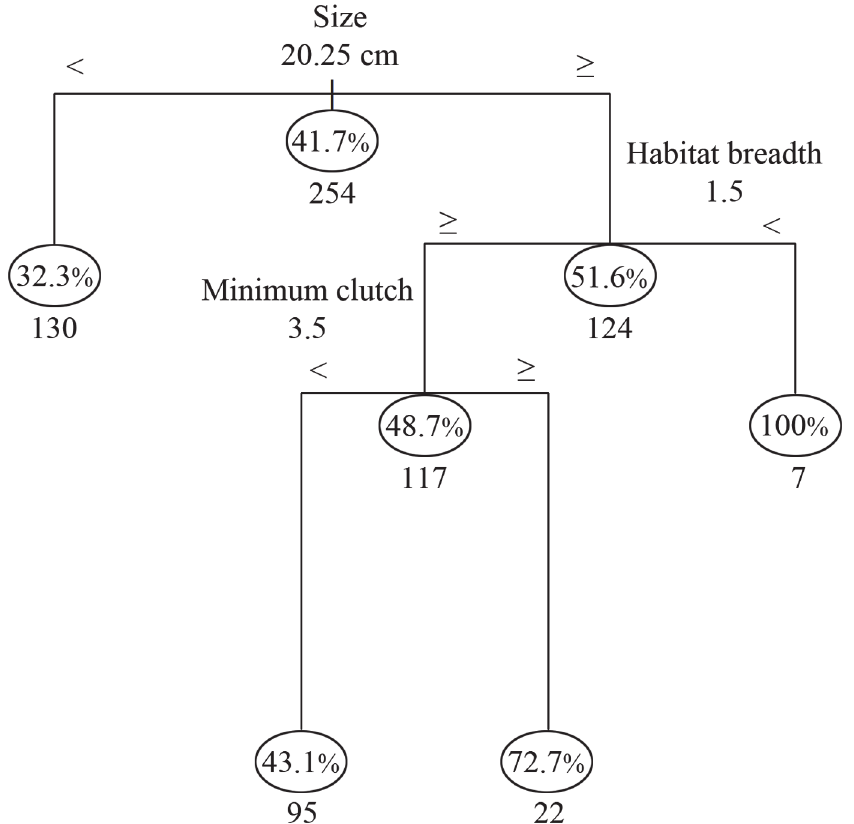
Fig 4. Classification tree showing extinction probabilities of birds in Mengsong based on life history and ecological traits. Body size, habitat breadth and minimum clutch size emerged as the only important factors in our analysis. The percentage in ovals refer to the probability of extinction and numbers below the ovals are the number of species at each node. Species with higher extinction risk are to the right of each branch